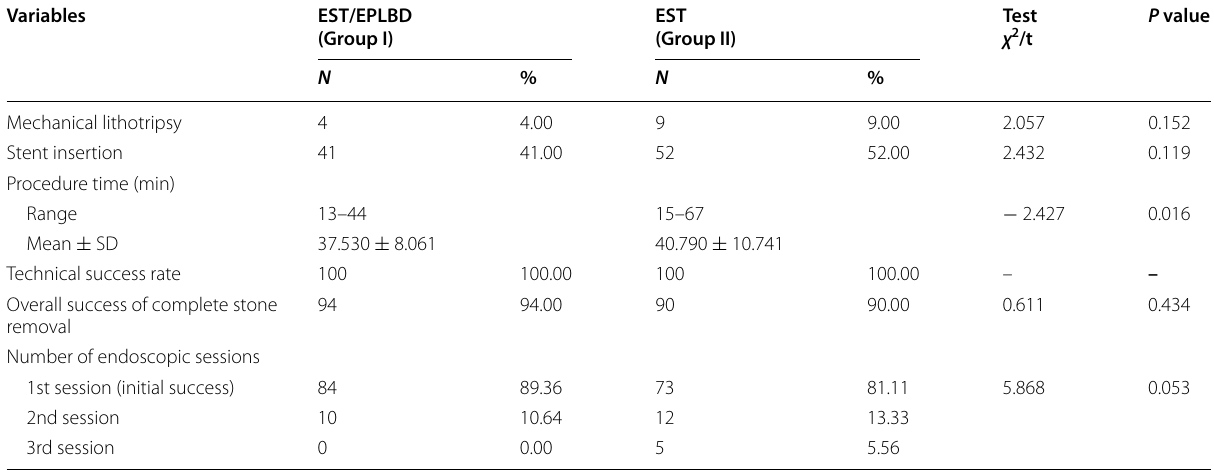
χ 2 chi-square, t t test, SD standard